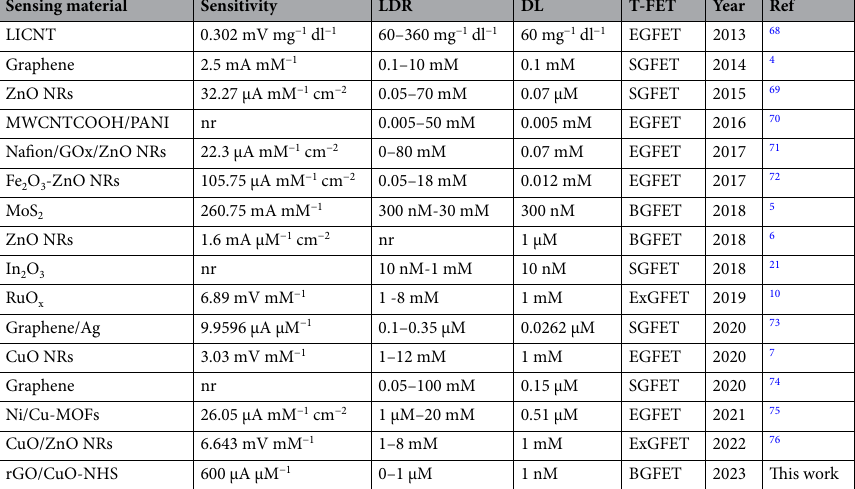
Table 2. Comparison of the proposed glucose sensor with other reported sensors. LDR linear dynamic range, DL detection limit, T-FET type of FET, Ref References, LICNT Laser-irradiated carbon nanotube thin films,